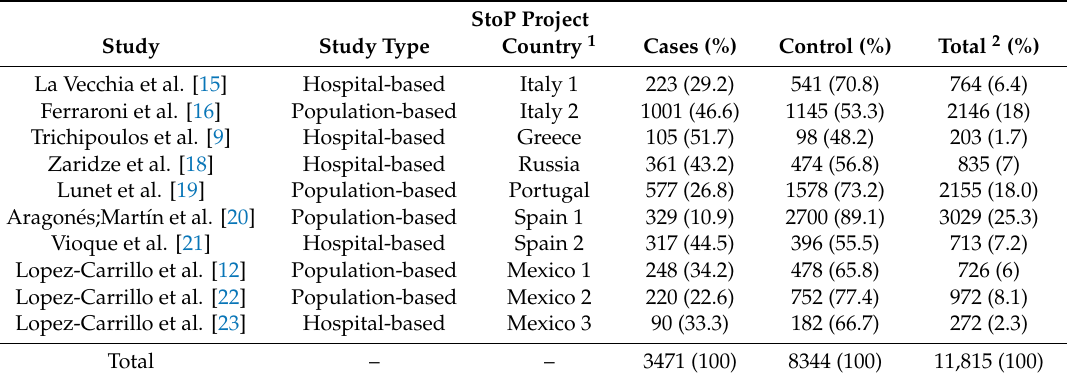
Table 1. Distribution of 3471 gastric cancer cases and 8344 controls of each study included in the StoP (Stomach cancer Pooling) Project (version